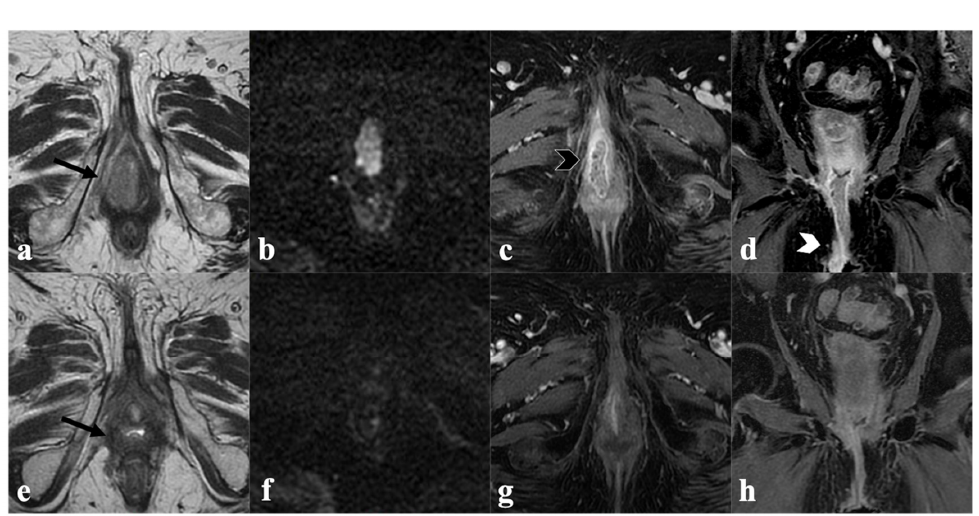
Figure 2. Complete response to CRT. An 85-year-old patient with locally advanced vulvar cancer (FIGO stage IIIA) treated with CRT, showing complete response to treatment. Baseline MRI (upper row) with axial T2-weighted (( a )—black arrow) axial DWI ( b ) post-contrast fat-saturated axial ( c ) and coronal ( d ) T1-weighted images shows infiltrative vulvar tumor involving, anteriorly, the clitoris and urethral meatus (black arrowhead in ( c )), posteriorly, the fourchette, and cranially, the lower third of vaginal introitus (white arrowhead in ( d )). MRI after CRT (bottom row) shows absence of a T2 intermediate signal intensity mass (( e )—black arrow), no hyperintensity in DWI ( f ), and no enhancement in post-contrast images ( g , h ) consistent with complete response.